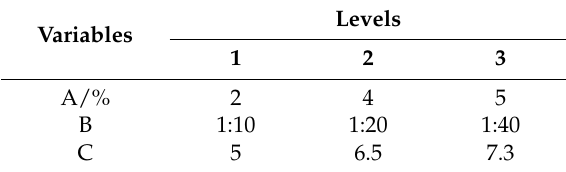
Table 1. Independent variables and the corresponding levels in the orthogonal experiment design.